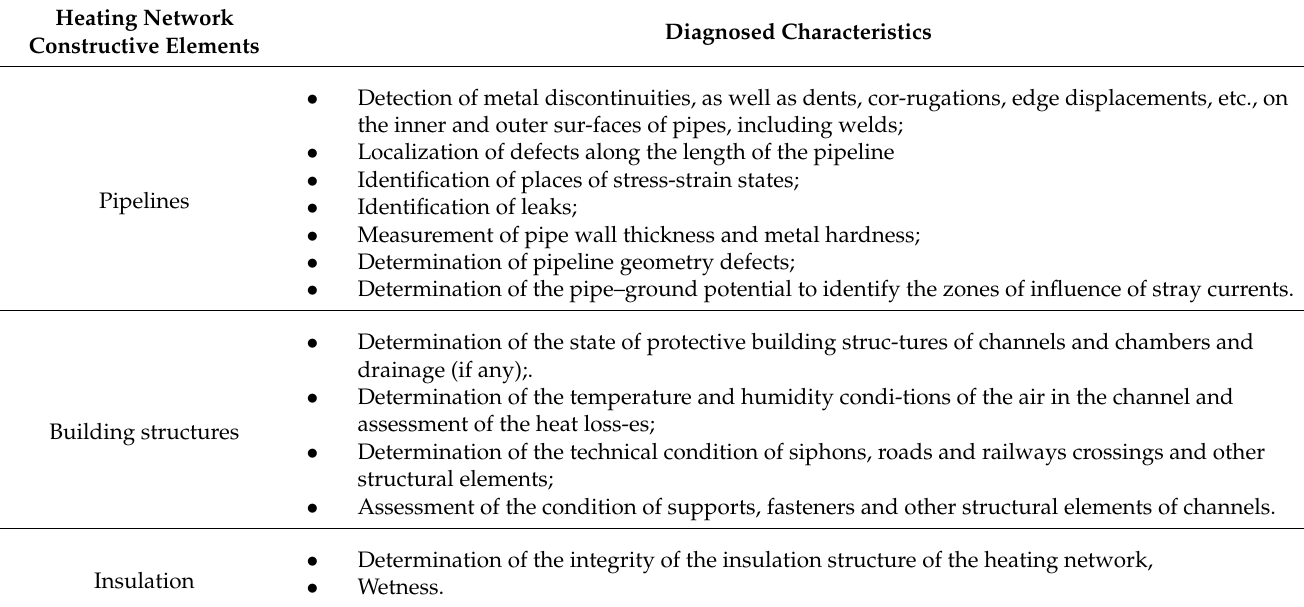
Table 1. The required diagnosed characteristics of heating